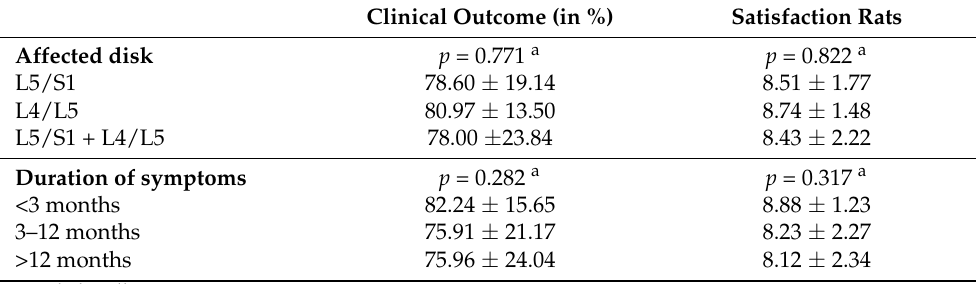
Table 2. Comparison of outcome measures (mean ± standard deviation) in patients with different affected disc levels and different durations of